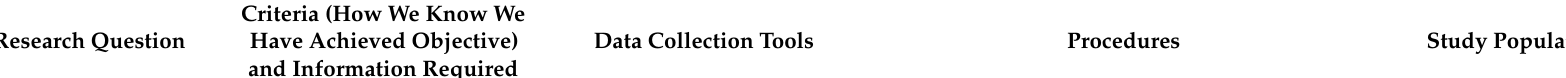
Table 1. Outline of criteria, data collection tools procedures, study population, and analyses required for each research